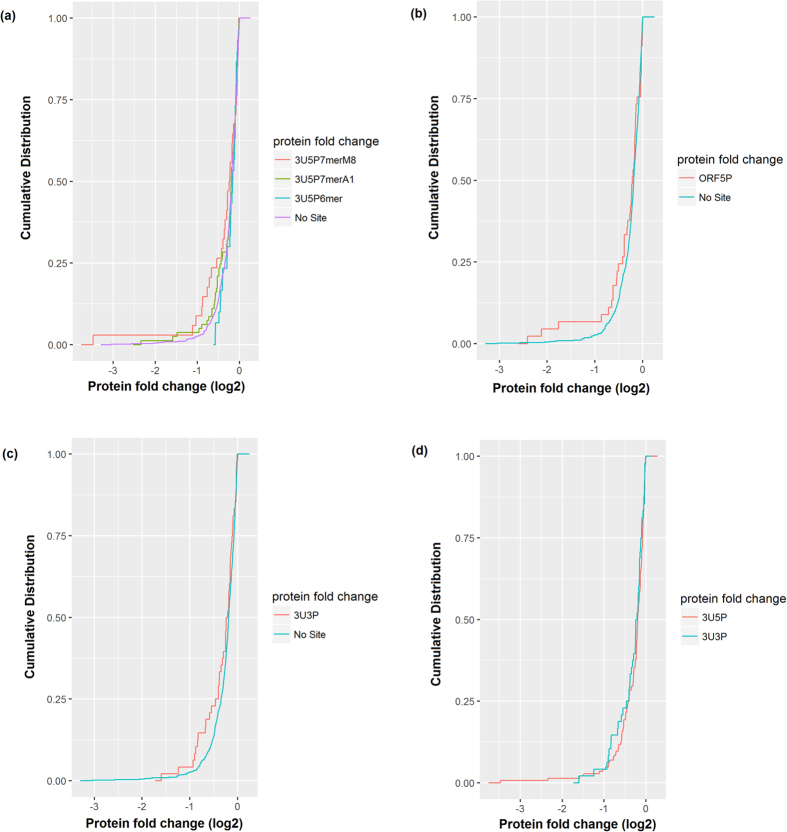
(a) The cumulative distribution plot of protein fold changes (log2) after miRNA transfection for targets with one miRNA 5′ end 6-mer (3U5P6mer, red line) or 7-merA1 (3U5P7merA1, green line) or 7-merm8 (3U5P7merM8, cyan line) site in the target’s 3′ UTR versus that of the targets with no miRNA site (purple line) in the target. Here 6-mer sites are exclusively those sites which contain a 6-mer seed match in miRNA position 2–7. Similarly, 7-merA1 sites contains the nucleotide ‘A’ in the target opposite of the 1st nucleotide in the miRNA sequence followed by 6-mer seed match in miRNA position 2–7 and 7-merM8 sites contains 7-mer seed matches in miRNA position 2–8. The 6-mer sites do not include in the larger 7-merA1 or 7-merM8 sites. All number of sites for all types (6-mer, 7-merA1 and 7-merM8) combines the number of conserved and non-conserved sites in the respective category. Targets with only one 7-merA1 site and targets with only one 7-merm8 site showed more repression in protein level than that of the targets with no miRNA site. But the targets with only one 6-mer site did not show more repression in protein level than the targets with no site, signifying that only one 6-mer miRNA site did not significantly affect target repression in protein level. (b) The cumulative distribution plot of protein fold changes (log2) after miRNA transfection for targets with one miRNA 5′ end site in the target’s ORF (ORF5P, red line) versus that of the targets with no miRNA site (cyan line) in the target. (c) The cumulative distribution plot of protein fold changes (log2) after miRNA transfection for targets with one miRNA 3′ end site in the target’s 3′ UTR (3U3P, red line) versus that of the targets with no miRNA site (cyan line) in the target. (d) The cumulative distribution plot of protein fold changes (log2) after miRNA transfection for targets with one miRNA 5′ end site in the target’s 3′ UTR (3U5P, red line) versus that of the targets with one miRNA 3′ end site in the target’s 3′ UTR (3U3P, cyan line).